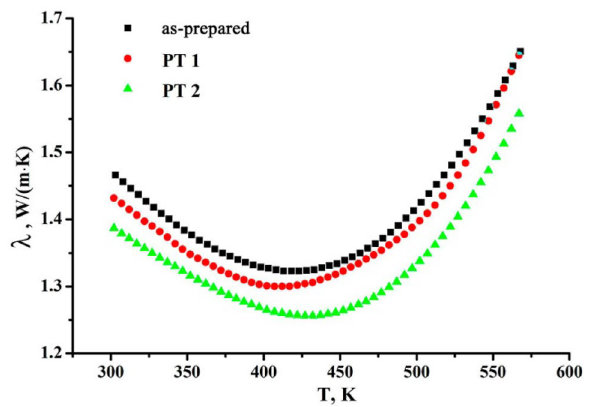
Fig. 6 Temperature dependence of the thermal conductivity of the as- prepared sample, and the samples after the single PT (PT1 curve) and double PT (PT2 curve)